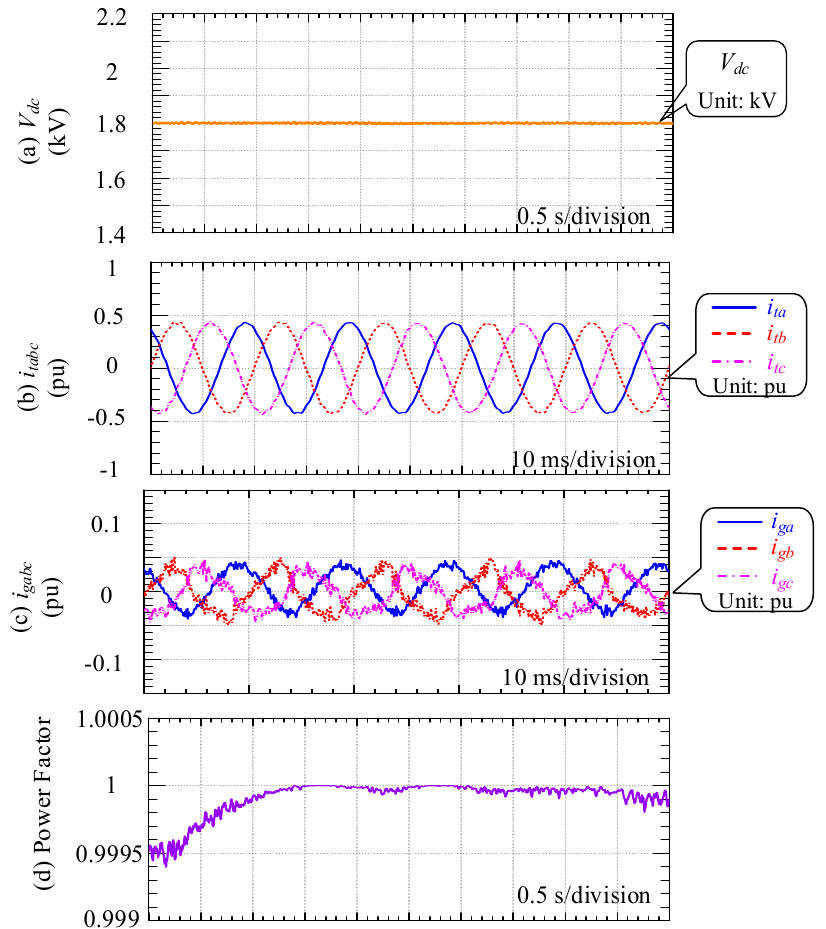
Figure 14. ( a ) DC-bus voltage V dc ; ( b ) three-phase GSC currents i gabc ; ( c ) three-phase total output currents i tabc ; and ( d ) the output power factor with wind speed fluctuation.